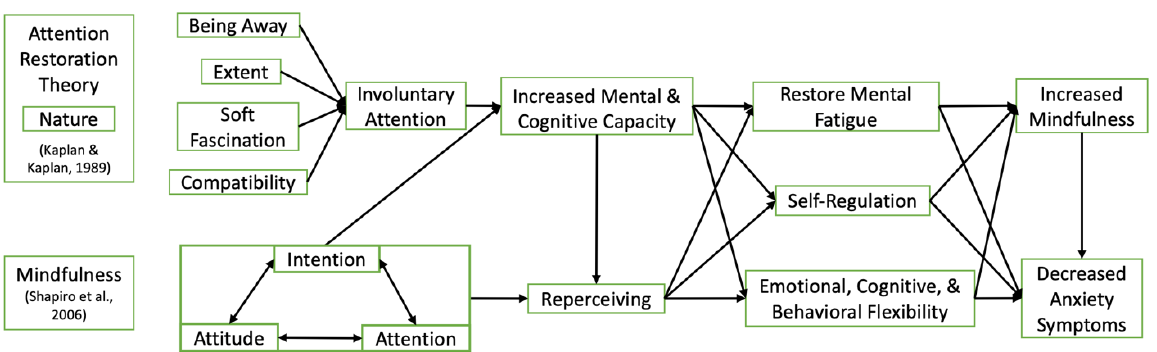
Figure 1. Integrating Core Components of Attention Restoration Theory and Mindfulness [12,13].